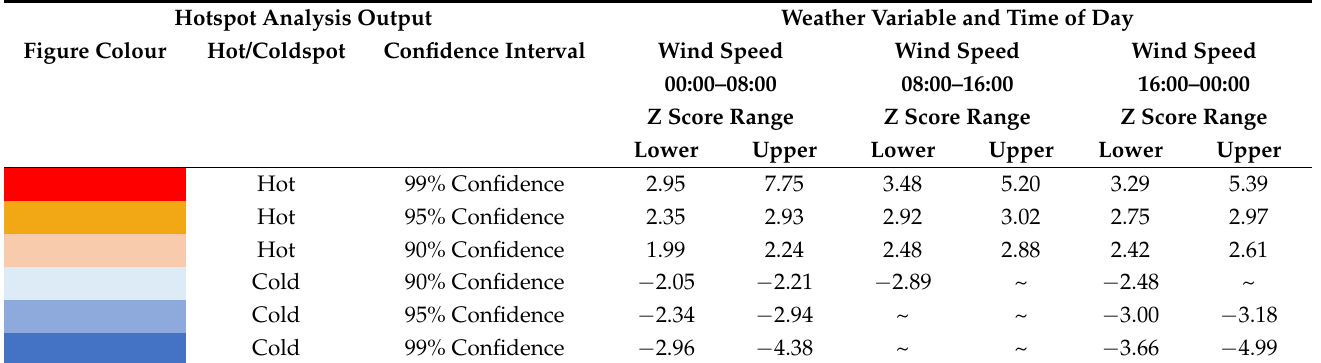
Hotspot Analysis Output Weather Variable and Time of Day